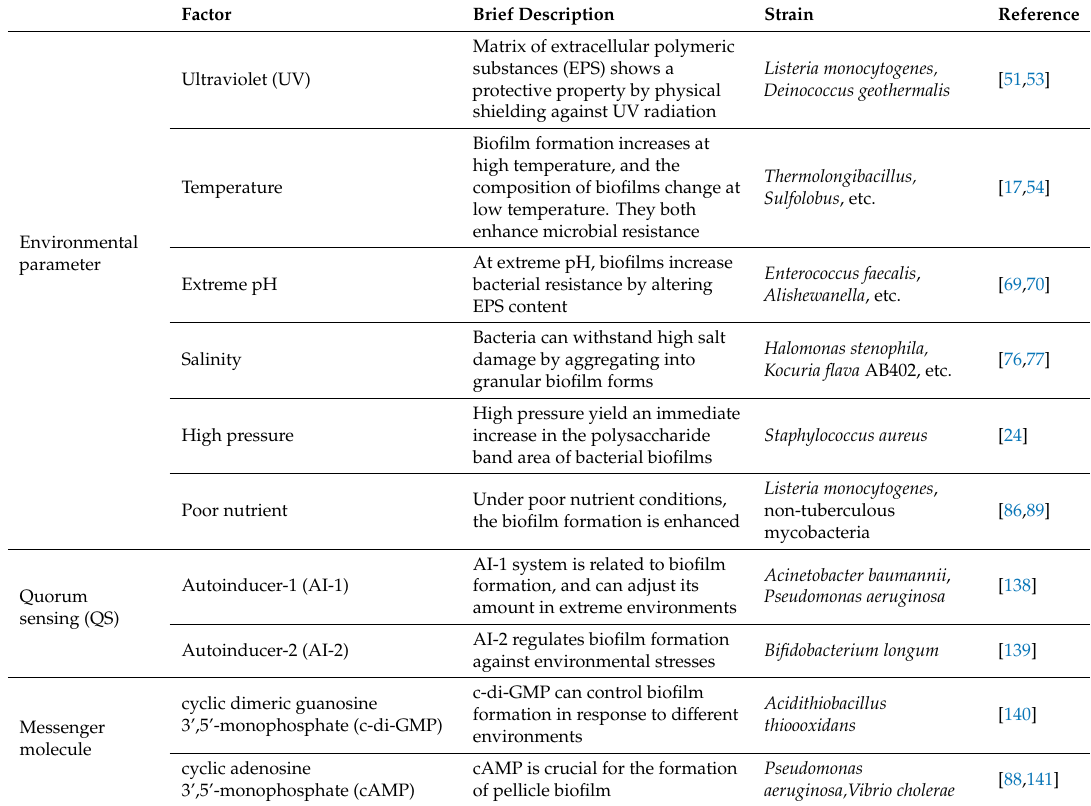
Table 1. Main a ff ecting factors in biofilm